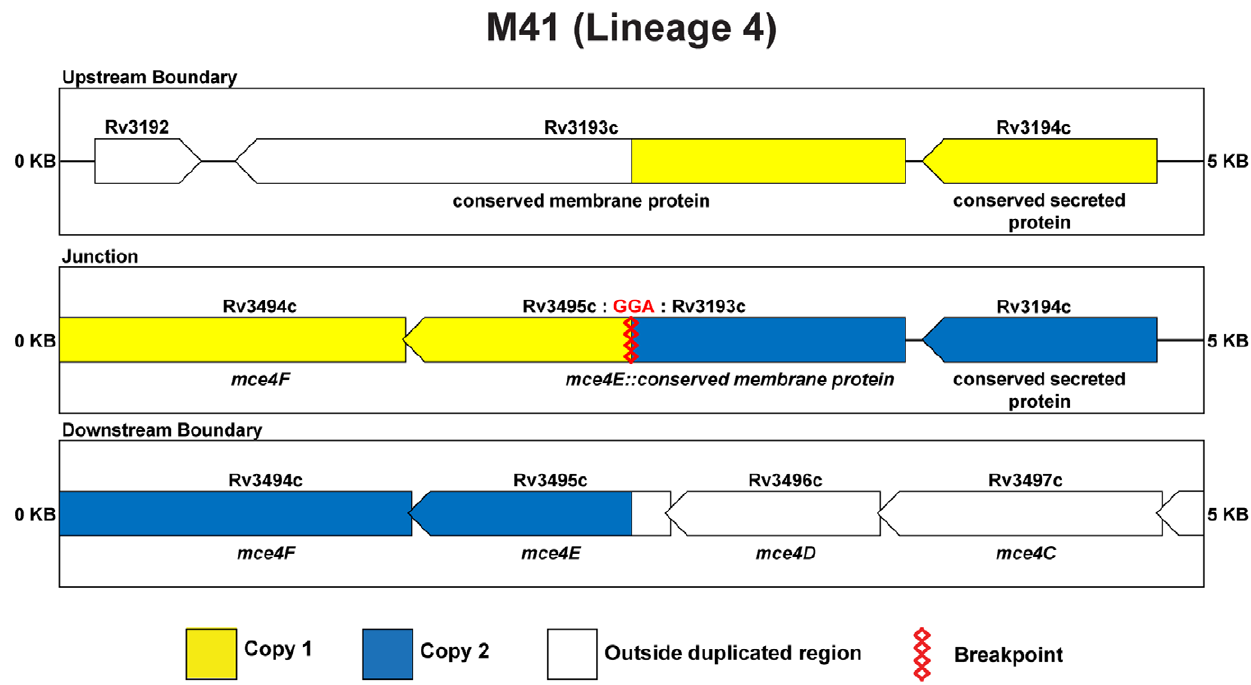
Figure 5. Schematic of duplication boundaries and junctions for M41. Genes within the tandem duplications are color coded. Genes in yellow are present in the upstream duplication copy, while genes in blue are present in the downstream copy.